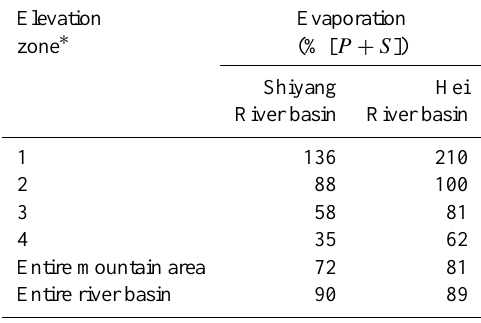
∗ Zones are classified according to elevation bands, i.e. < 2500m (zone 1), 2500–3300m (zone 2), 3300–3900m (zone 3), and > 3900ma.m.s.l. (zone